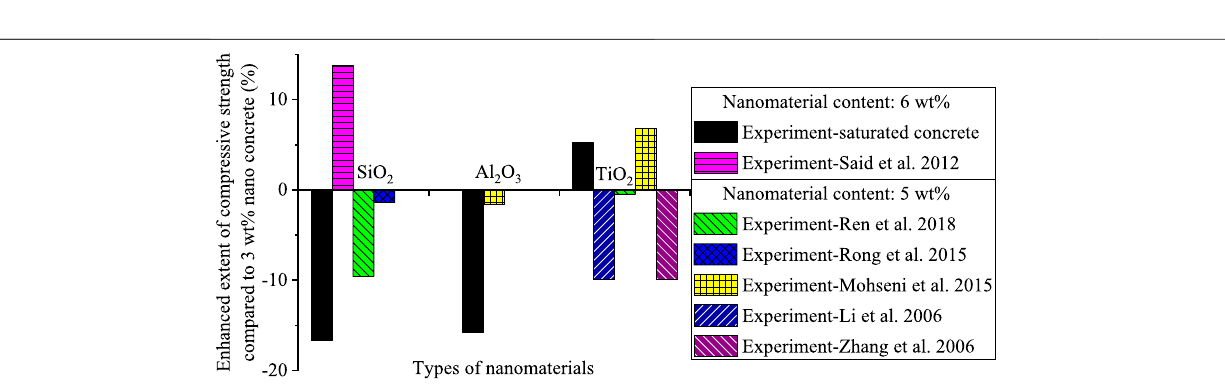
FIGURE 12 | The increase in compressive strength of nano-concrete containing more than 3 wt% nanomaterials compared to nano-concrete containing 3 wt% nanomaterials.